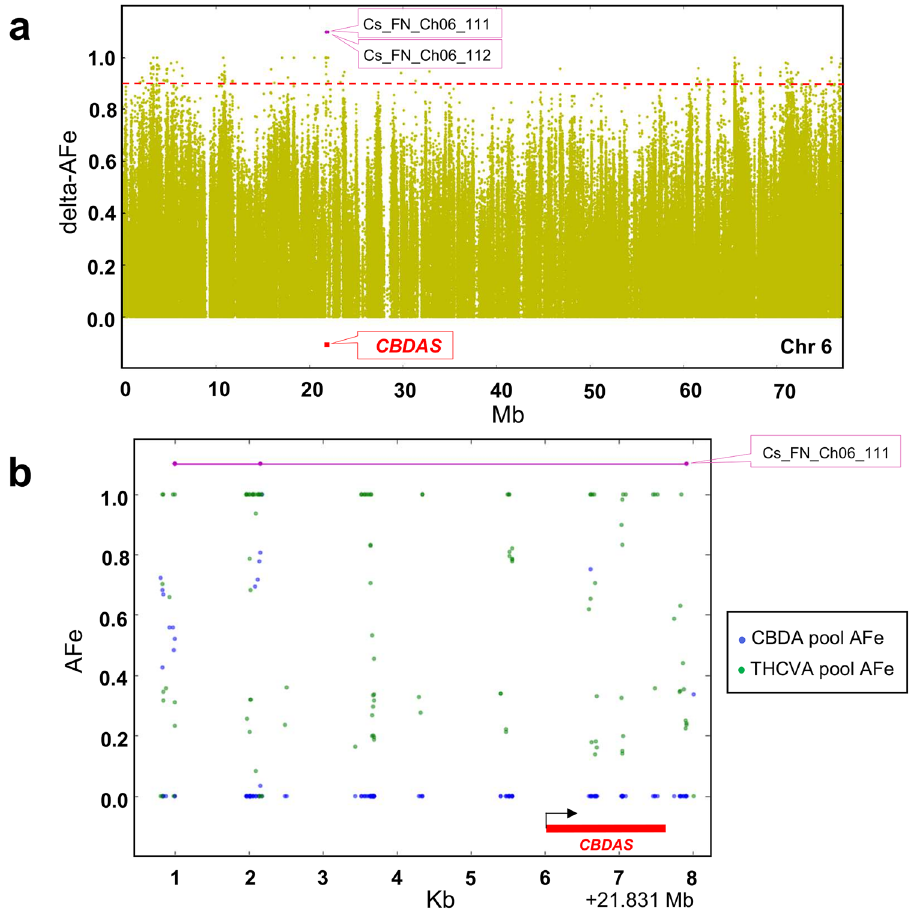
Figure 2. Detection of interval overlapping the CBDAS locus. ( a ) Plot of delta-AFe values encompassing two genomic regions (intervals) located within proximity to the chemotype determining CBDAS locus. AFe sorted by coordinate along chromosome six of the Cannabis sativa L. var. Finola (FN) genome. Delta-AFe indicates the absolute difference between AFe of CBDA and THCVA pools. Red dotted line indicates delta-AFe of 0.9. ( b ) Plot of AFe for the interval overlapping the 1632-nucleotide open reading frame of CBDAS . To reduce background noise, only delta-AFe supported by 0.75–2.5 × the average depth of coverage was plotted. Black arrow indicates orientation of gene (+/− strand). Pink line indicates genomic interval. Intervals displaying delta-AFe values of ≥ 0.9 were delineated using an algorithm which plots contiguous AFe values ≤ 0.1 in the CBDA pool (see “Methods”); AFe: allele frequency estimates; CBDAS : gene encoding cannabidiolic acid